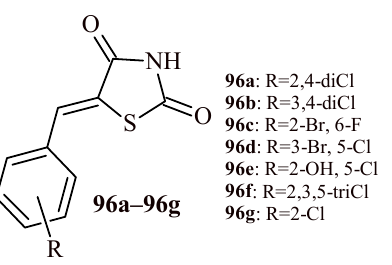
Figure 42. The 5-(Halogenbenzylidene)thiazolidine-2,4-dione derivatives with antileishmanial activity.